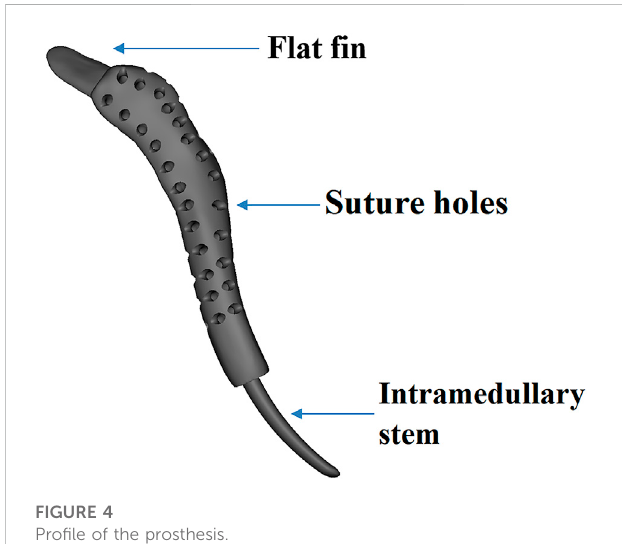
FIGURE 4 Pro fi le of the prosthesis.